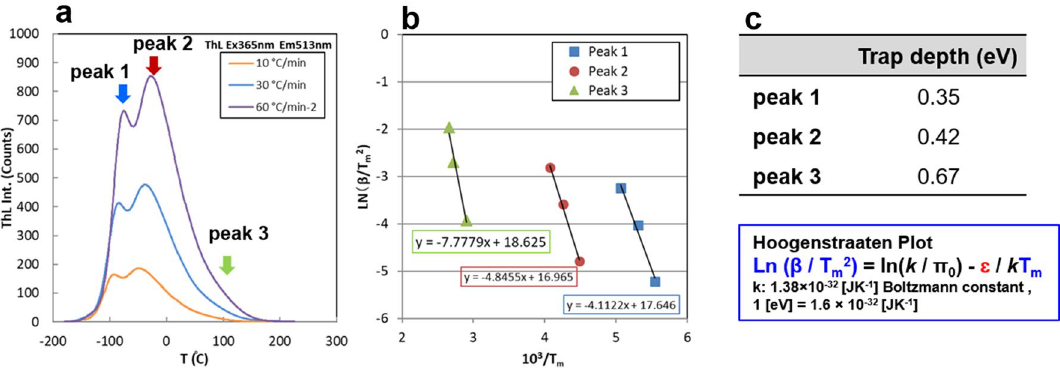
Figure 5. Thermoluminescence (TL) measurement of SrAl 2 O 4 : Eu 2+ as a SEL material. ( a ) TL curves measured at different heating rates. ( b ) Hoogenstraaten plots and c , Calculated trap depths.